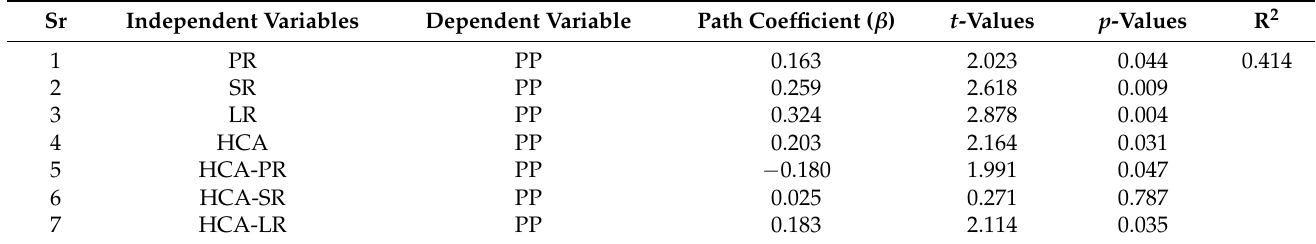
Table 9. Moderating effects